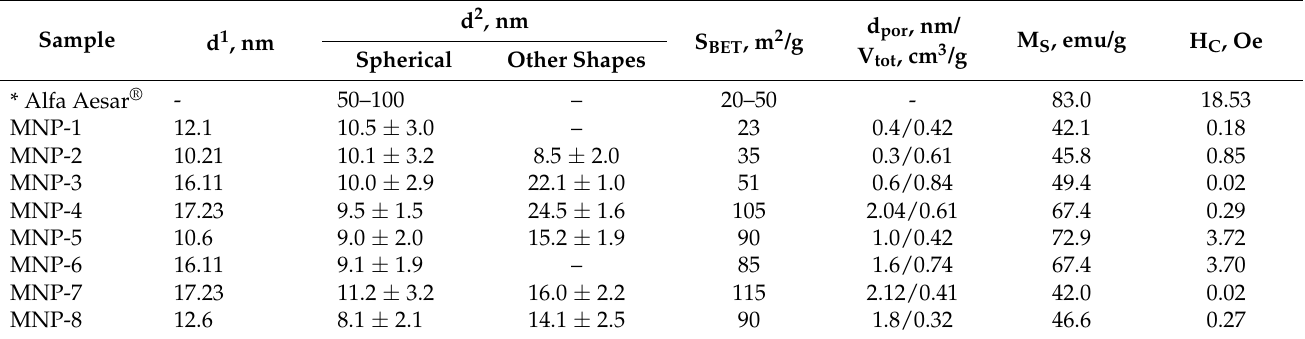
Table 1. Summary of main physical characteristics of the obtained